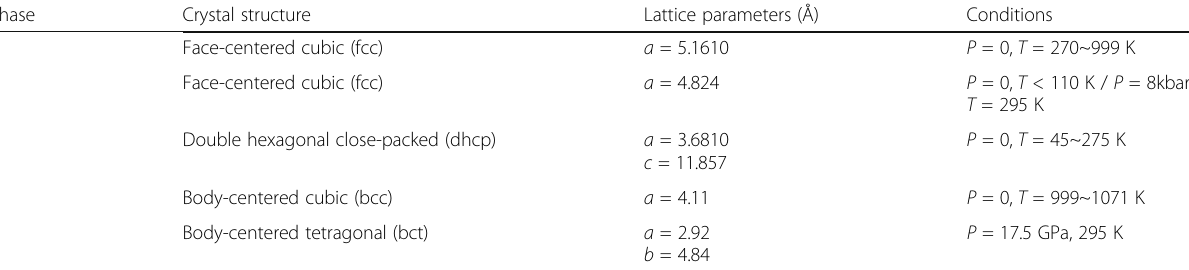
Table 1 Structural parameters and stable conditions of cerium phases [8 – 11] Phase